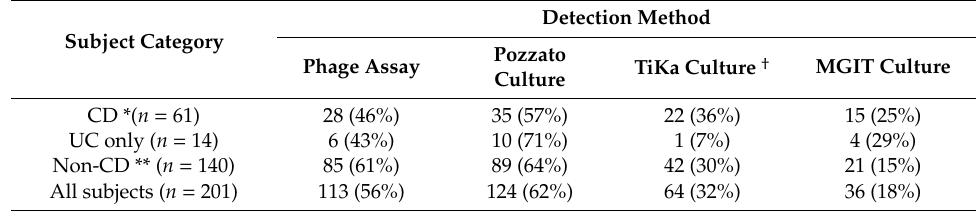
Table 2. Analytical sensitivity of MAP detection by phage assay and MGIT, TiKa and Pozzato culture methods among 201 study